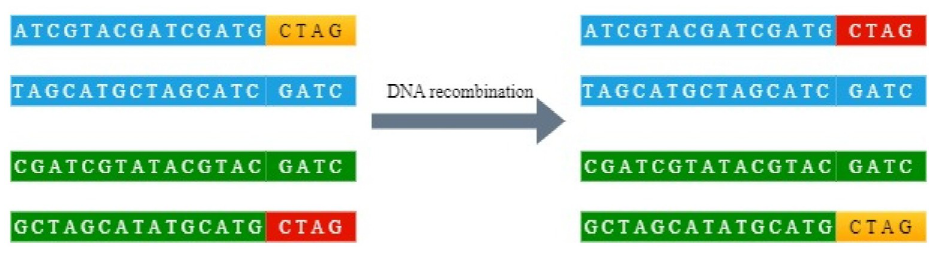
Fig 3. Schematic diagram of DNA